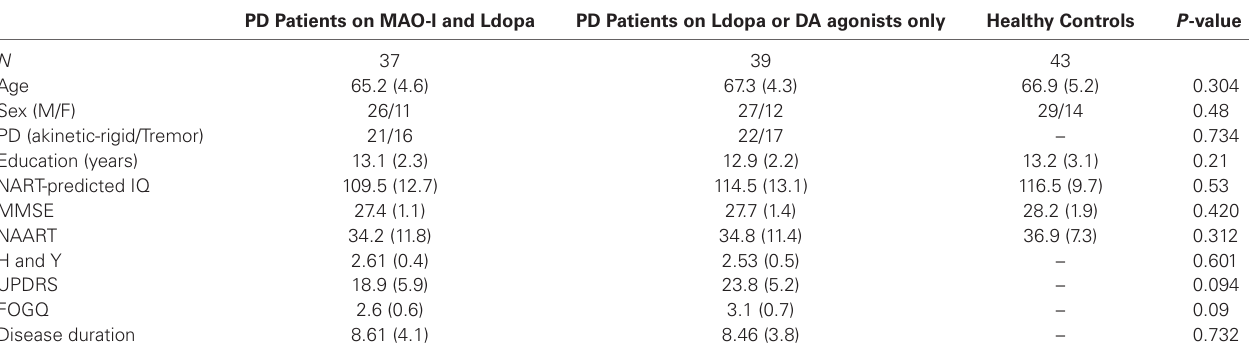
Table 1 | Subject demographic, clinical and data for healthy controls, PD patients on MAO-I and levodopa, and PD patients on monotherapy (levodopa or dopamine agonists only) . PD Patients on MAO-I and